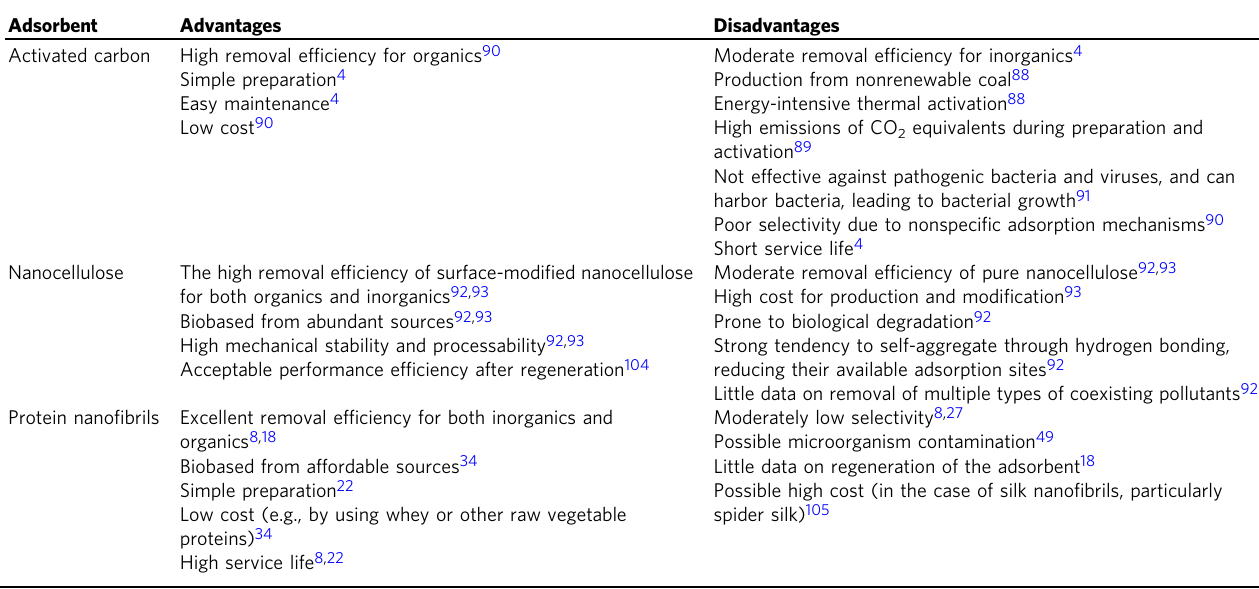
Table 1 Advantages and disadvantages of protein nano fi brils in water puri fi cation compared to activated carbon and